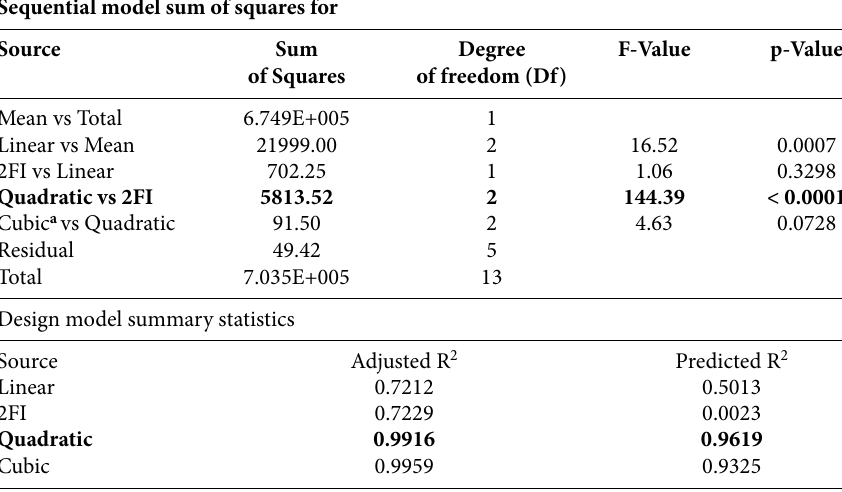
Table 4. Statistical model analysis of particle size